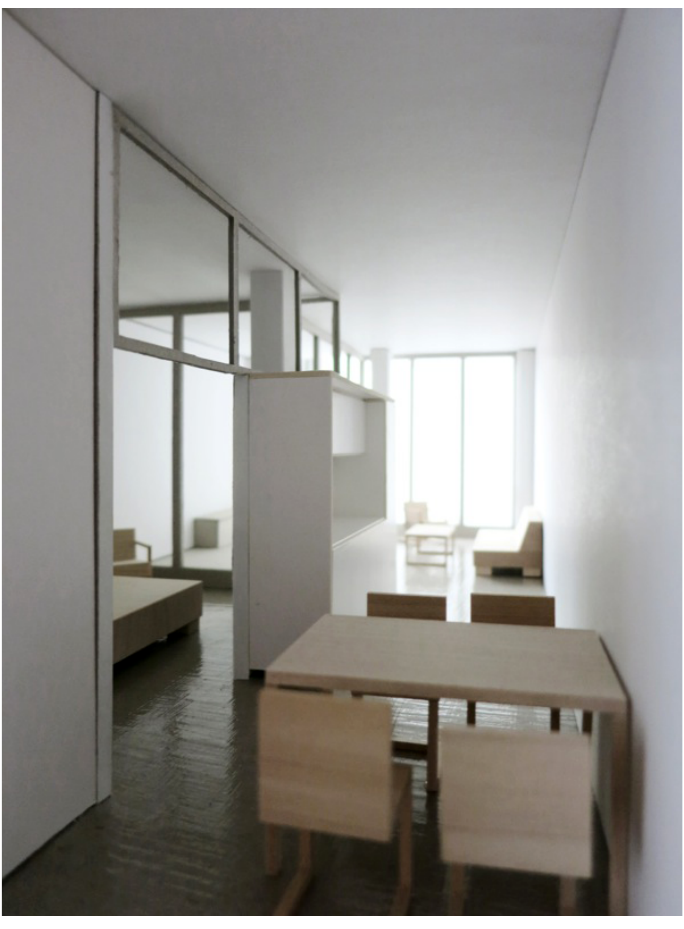
Figure 7. EMI Architekten, type MIN 1 of the Glattpark building (2013–2016), Opfikon, architectural model of the interior space. Image courtesy of EMI Architekten.